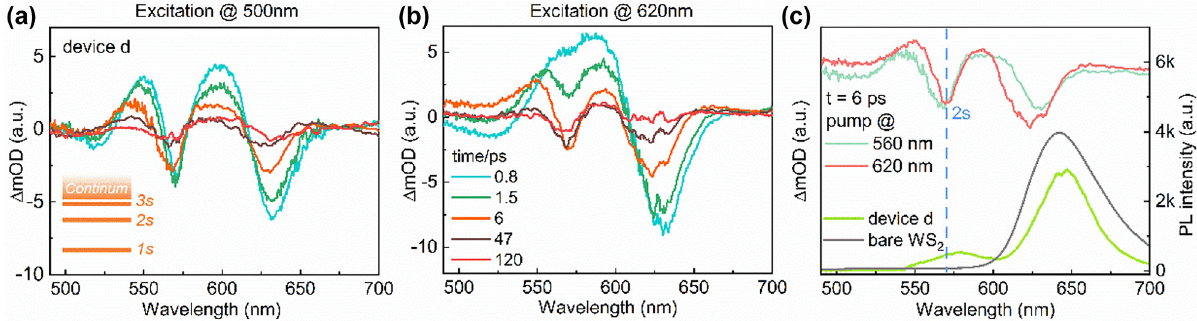
Figure 4: Ultrafast modulation of 2s Rydberg state in WS 500 nm (a) and 620 nm (b) excitation respectively. The insert picture in (a) shows internal exciton states of monolayer WS spectra of device d. The PL spectrum of bare monolayer WS